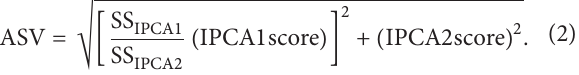
two weeks after planting, and stand counts were determined for all sorghum experimental units. Days to 50% heading were determined by calculating a number of days from sowing to when 50% of the sorghum heads in each plot had formed panicle. At dough stage of grain, plant height of each genotype was determined, and their panicles were harvested. Three randomly selected plants from each genotype in all replicates were used for recording plant height. Plant height was measured from base of the stem to tip of panicle and data averaged across three